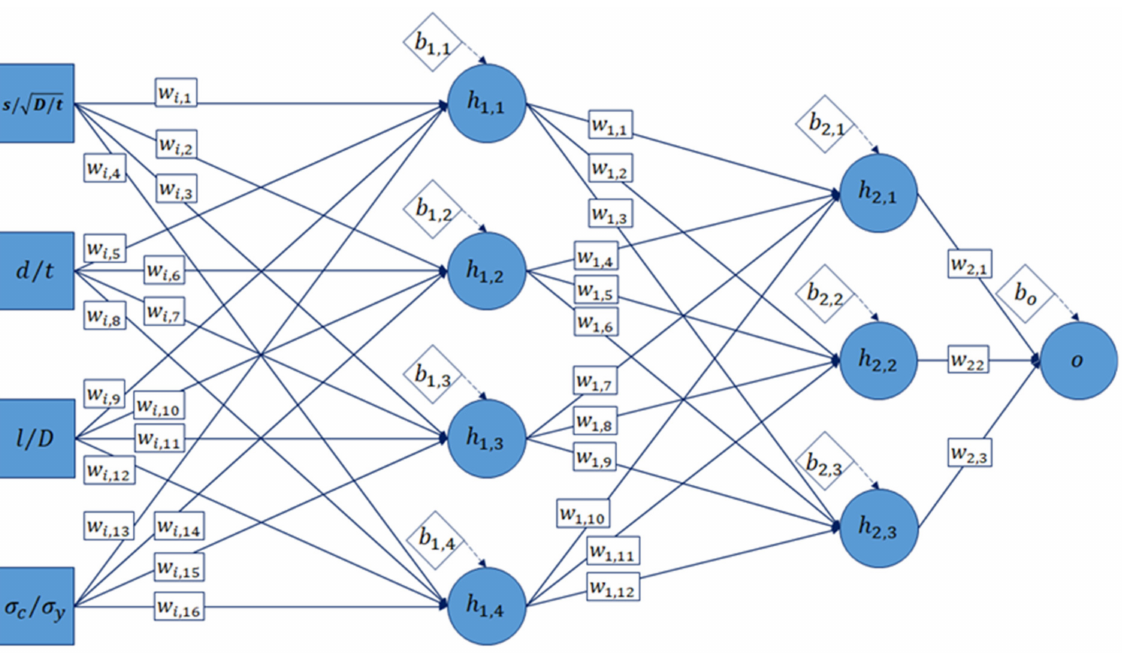
Figure 7. Architecture of the ANN